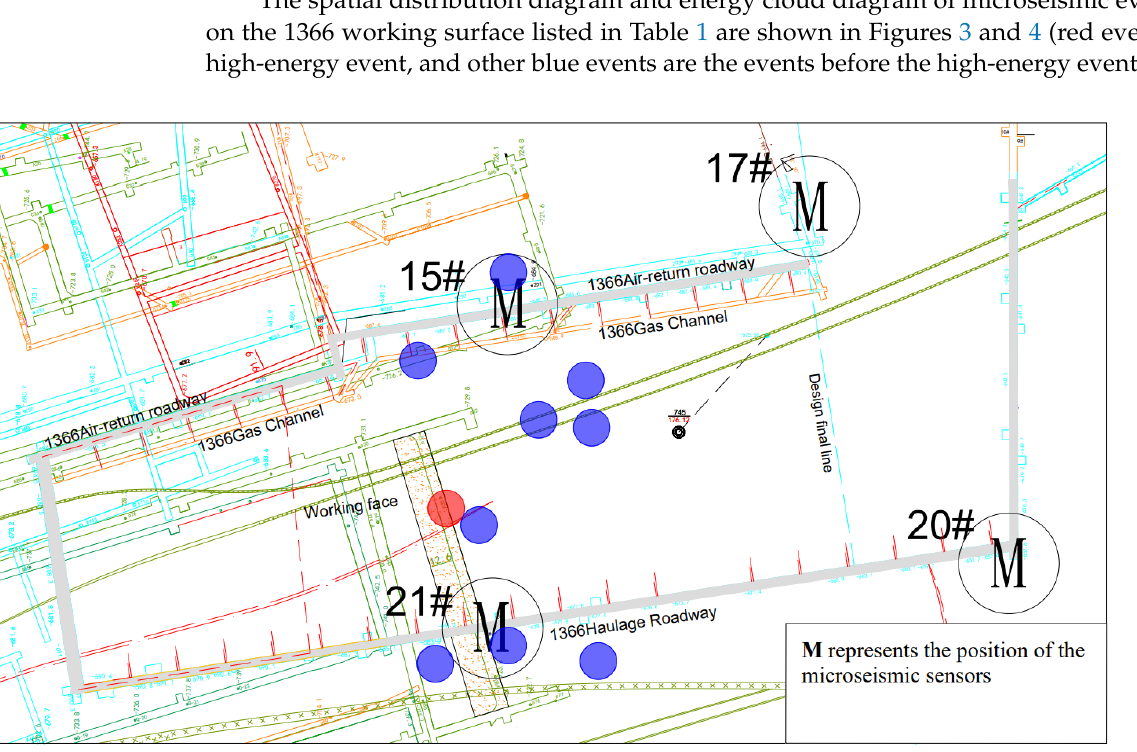
Table 1. Basic information of microseismic events in working face.